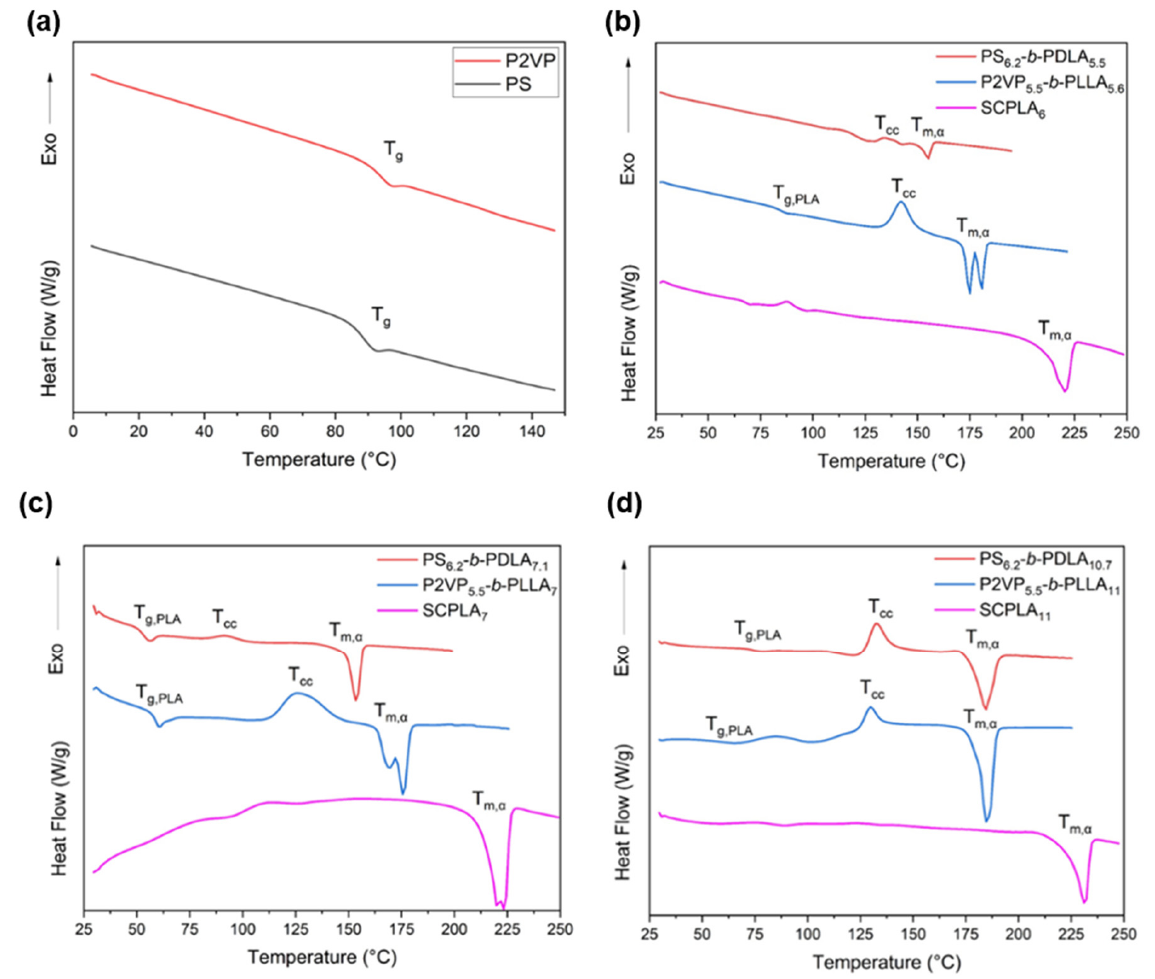
Figure 4. DSC thermograms of PS, P2VP homopolymers ( a ), PS- b -PDLAs, P2VP- b -PLLAs, and the corresponding SCPLAs with varying PLA segments with molecular weights of ( b ) 5 kg mol − 1 ( c ) 7 kg mol − 1 , and ( d ) 11 kg mol − 1 (heating scan 10 °C/min, under N 2 atmosphere).